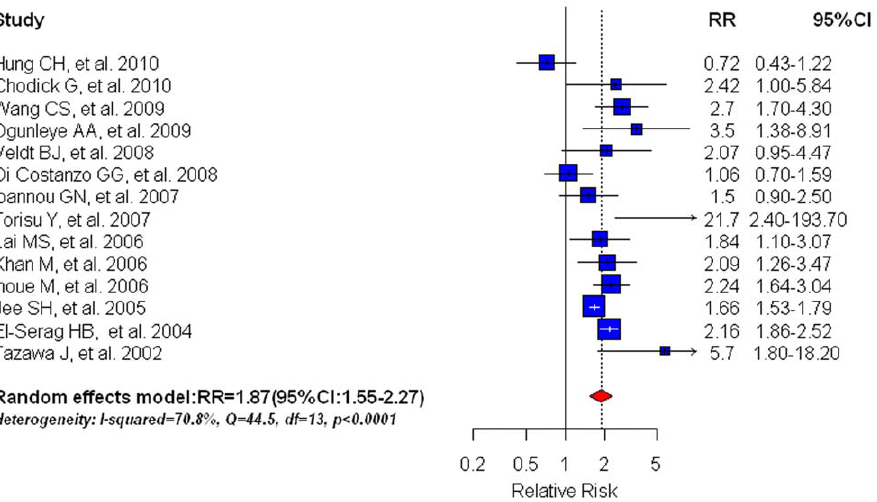
Figure 2. Summary estimate of relative risk (RR) for HCC incidence in diabetic patients in comparison with non-diabetic patients. Squares represent study-specific estimates (size of the square reflects the study-specific statistical weight, i.e. inverse of the variance); horizontal lines represent 95% CIs; diamonds represent summary estimates with corresponding 95% CIs.